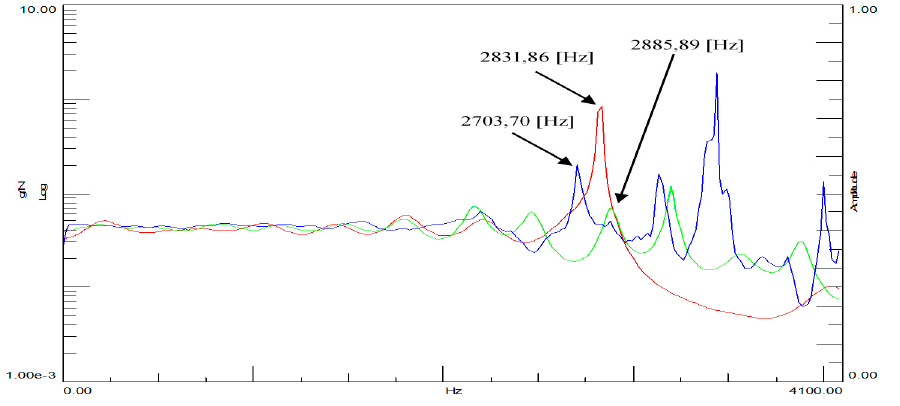
Figure 14. Spectral functions of the FRF transition for ordinary concrete cube. Legend: spectral transition function FRF (Side A), spectral transition function FRF (Side B), spectral transition function FRF (Page C).